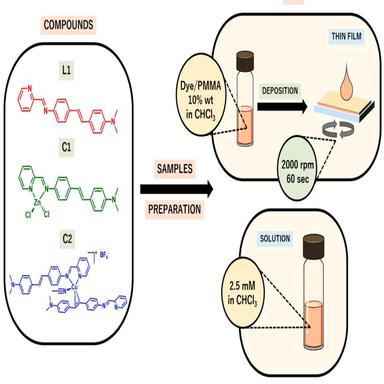
Schematically presented the L1, C1 and C2 samples preparation for nonlinear optical studies.